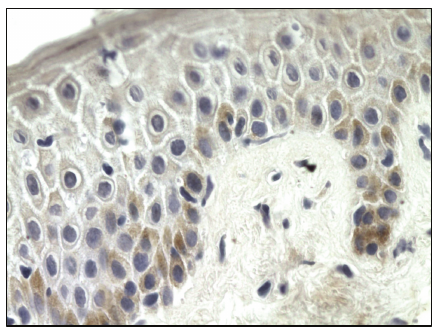
Figure 1: Cytoplasmic Bax immunoexpression in skin lesions, (score 2), 400x.